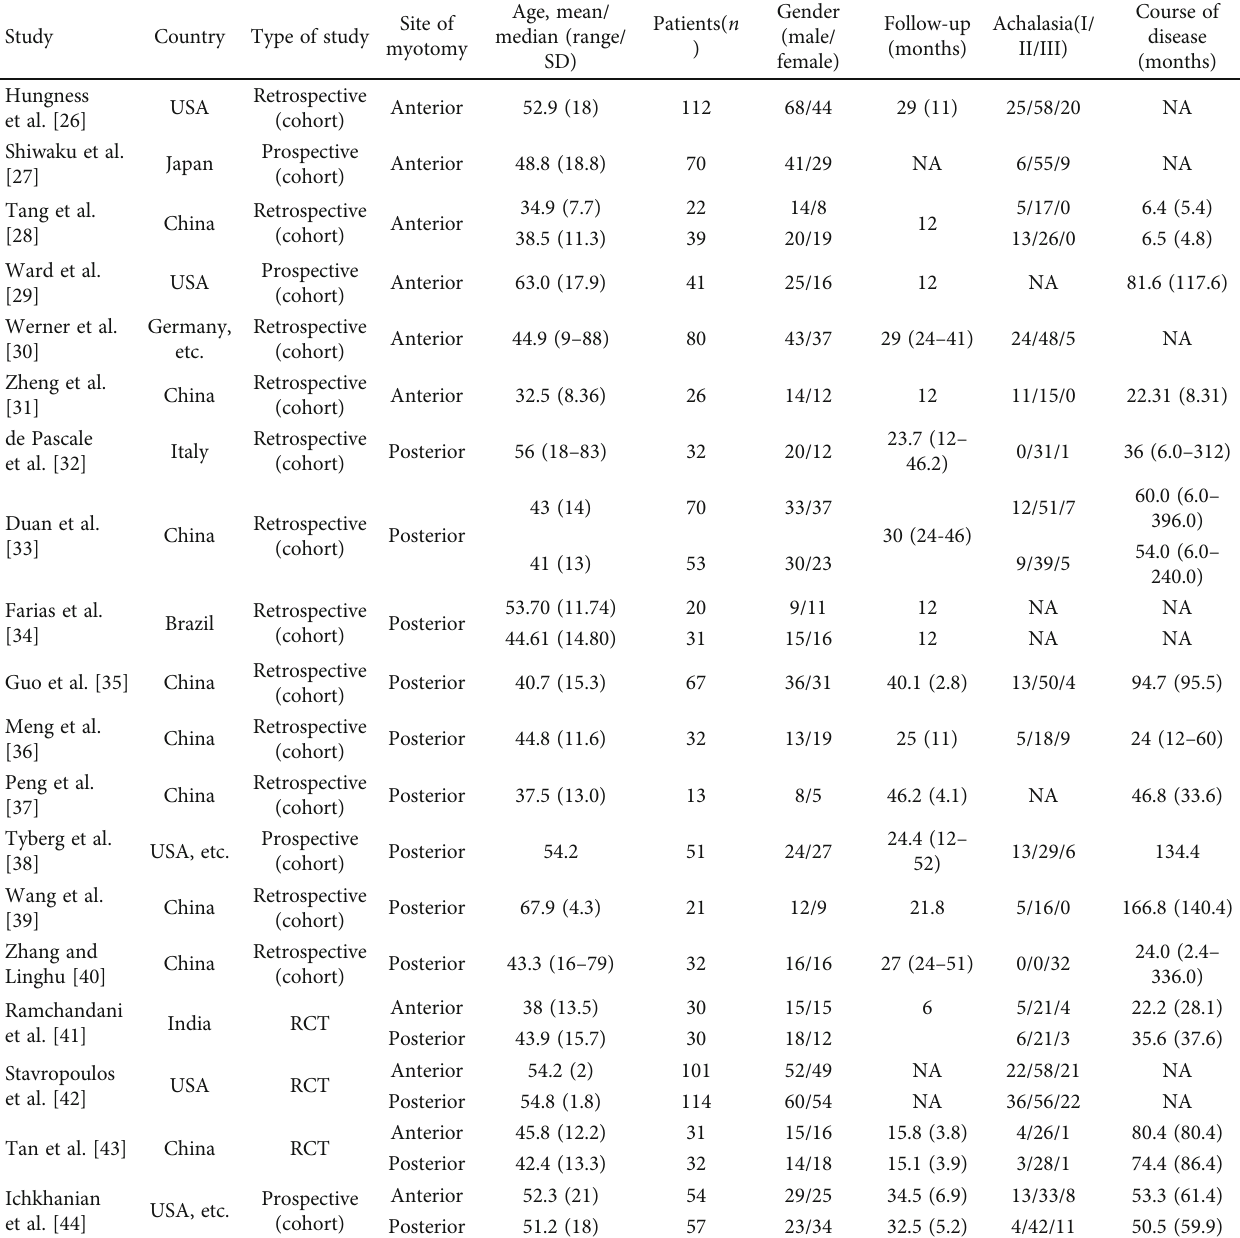
Table 1: Characteristics of included